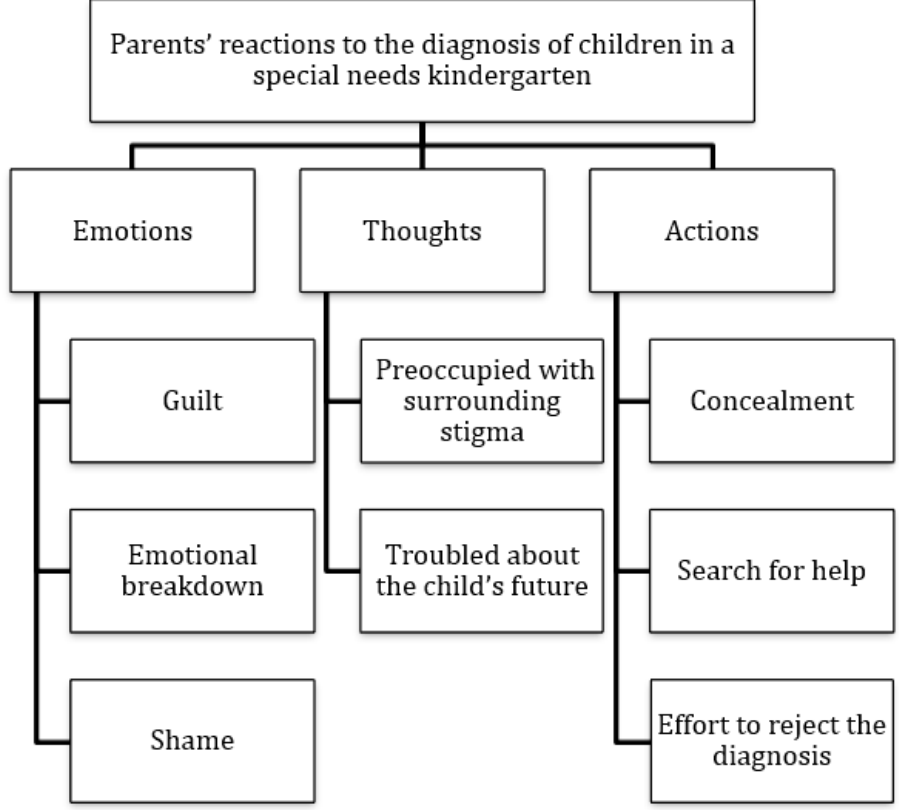
Figure 2. Map of themes as derived from data analysis.